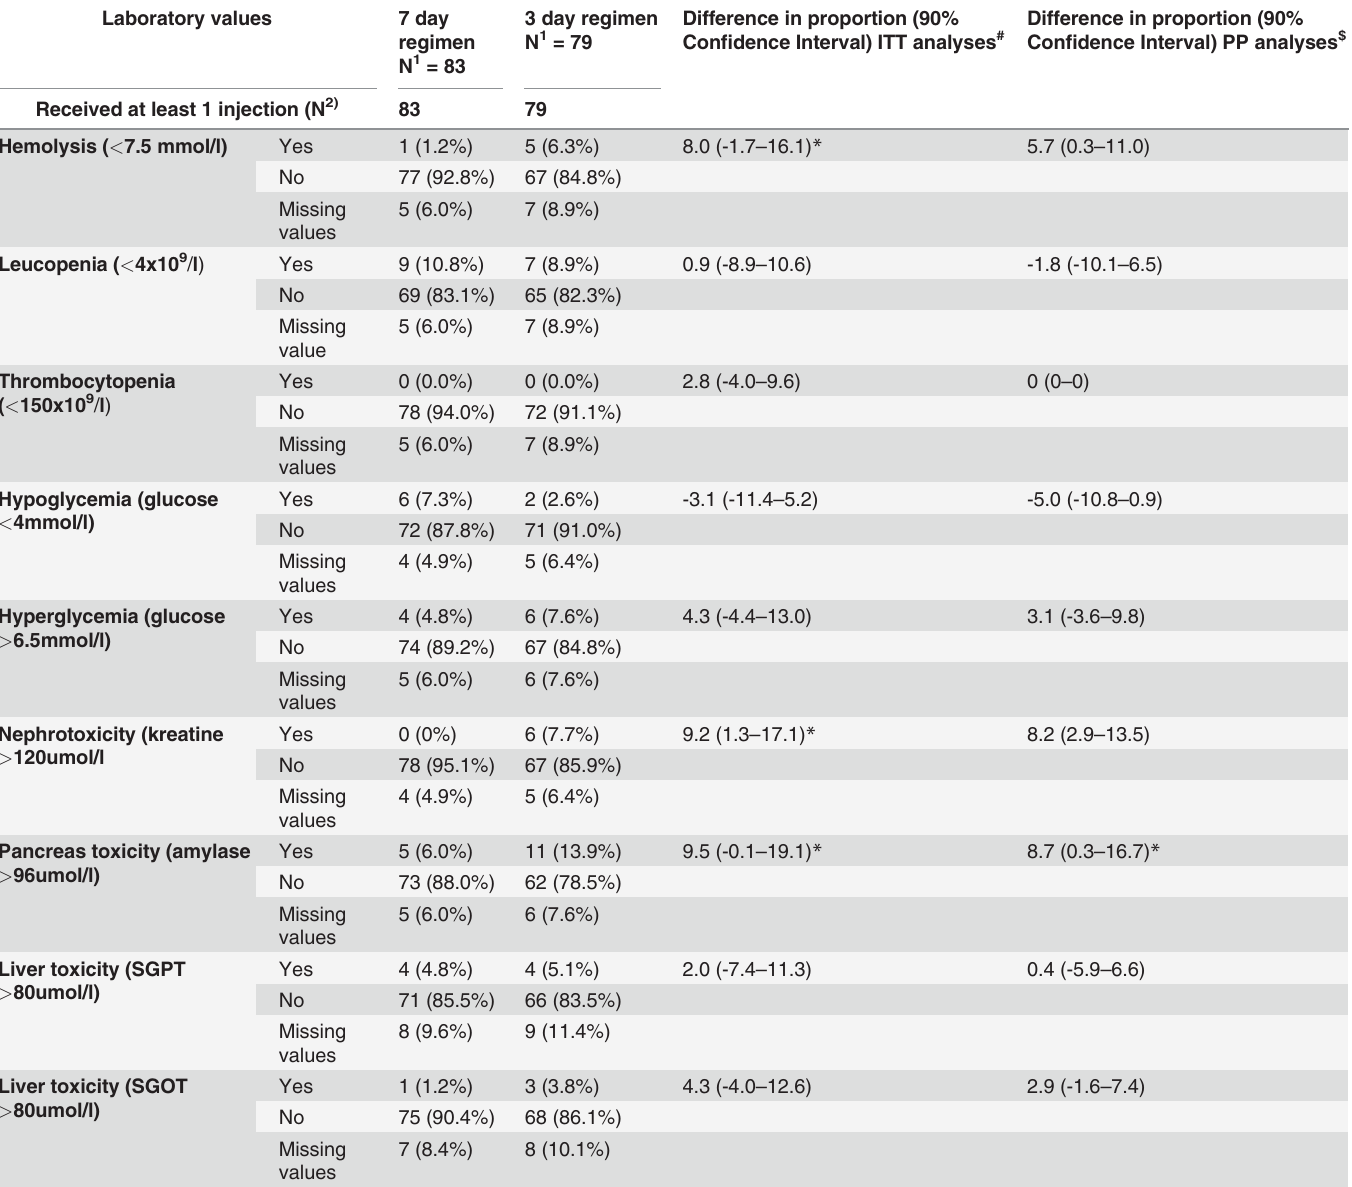
Table 5. Clinical laboratory values at follow-up 1 week after last treatment according to treatment group of cutaneous leishmaniasis patients in Su- riname from 2010 – 2013#. Laboratory